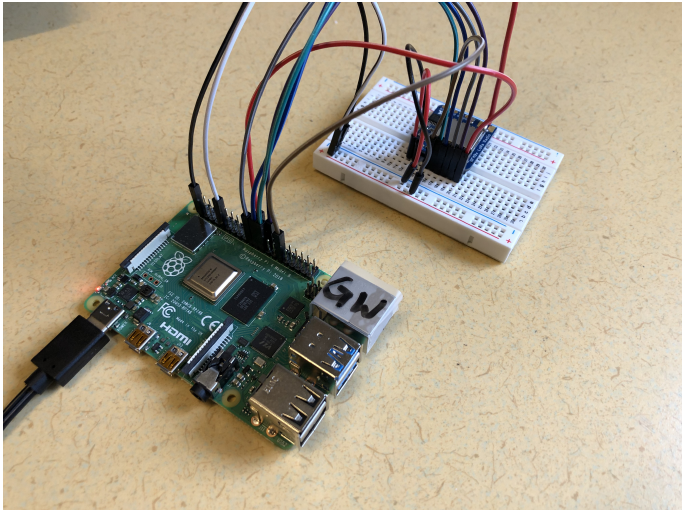
Figure 4. Gateway hardware and wiring setup using RPi4 and RFM96W.